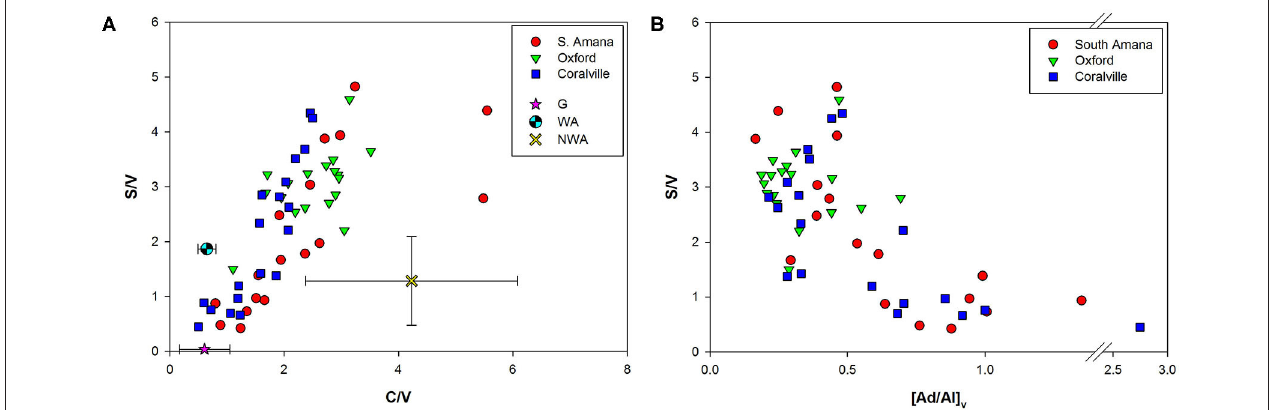
FIGURE 6 | (A) Lignin source identification biplot. Plant reference materials used include gymnosperms (G) (Red Spruce, Eastern White Pine, Red Cedar), woody angiosperms (WA) (Oregon White Oak wood), and non-woody angiosperms (NWA) (Oregon White Oak leaf, Red Alder, Smooth Cordgrass, Saltmarsh Hay, and Eel grass). (B) S/V and [Ad/Al] v biplot. Increases in [Ad/Al] v indicate oxidative degradation of